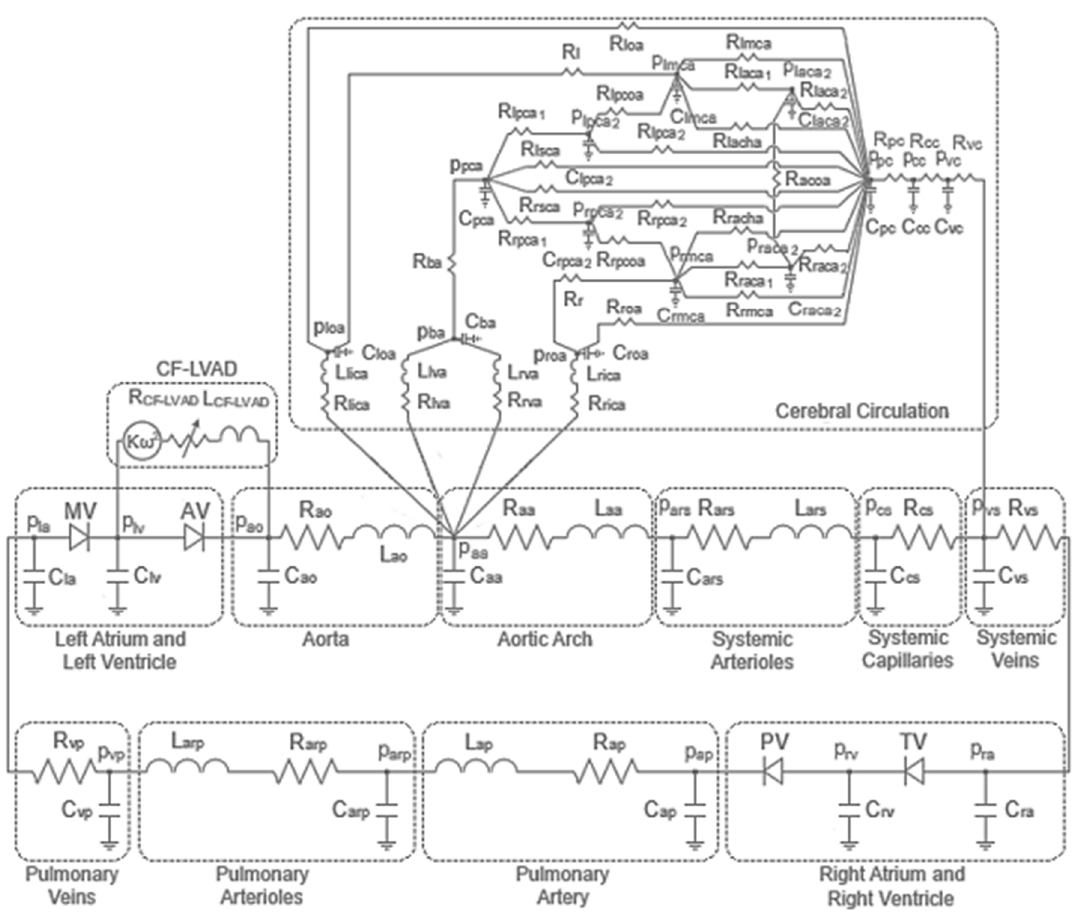
Figure 2. The electric-analogue of the heart chambers and circulatory loop used to simulate normal sinus rhythm and atrial fibrillation with unimodal and bimodal RR interval distributions for heart failure and Continuous Flow Left Ventricular Assist Device (CF-LVAD) support.